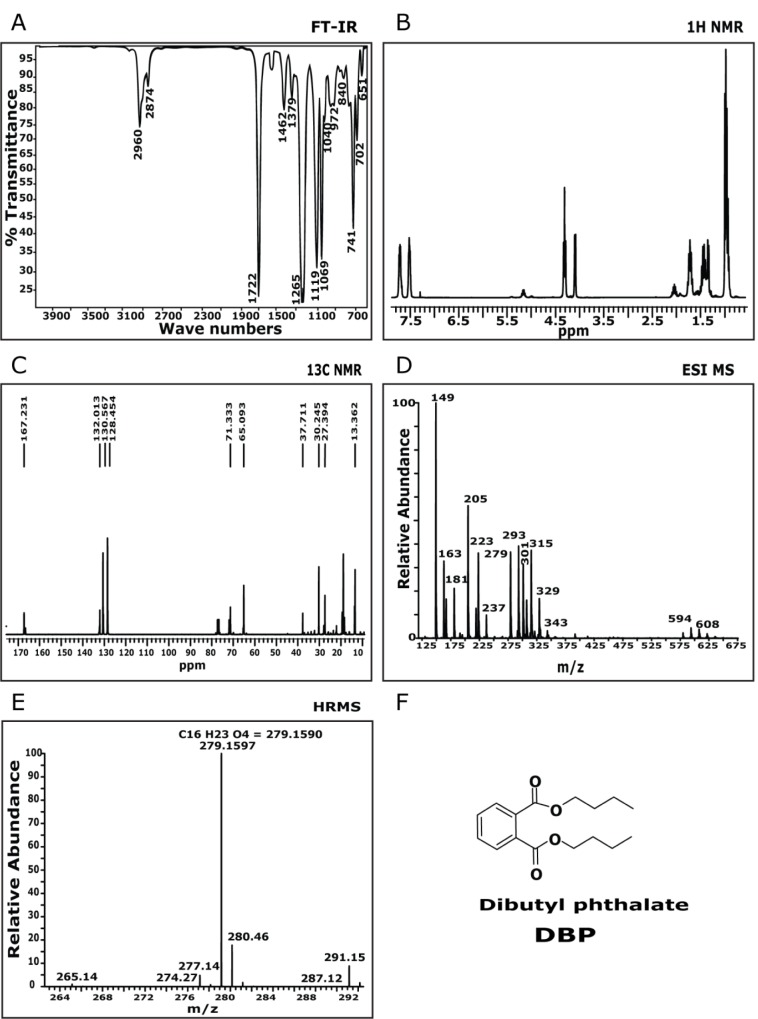
Chemical characterization of dibutyl phthalate: A) FT-IR spectra showed peaks at 2960, 2874, 1722, 1265, 1462, 1265, 1119, 1069, 741, 651 cm-1. B) 1H NMR spectra showed peaks at δ 7.73-7.70 (m, 2H), 7.53-7.50 (m, 2H), 4.3 (t, 2H), 4.10-4.08 (d, 1H), 2.08-2.02 (m, 1H), 1.47-1.33 (m, 4H), 0.97 (t, 7H). C) 13C NMR spectra showed peaks at d 13.3, 18.8, 132.0, 167.2. D) MS(ESI): (m/z) = 279 (M+1)+. E) HRMS (ESI) (M+1)+ m/z calcd for C16H23O4 = 278.1597, found = 279.1590.